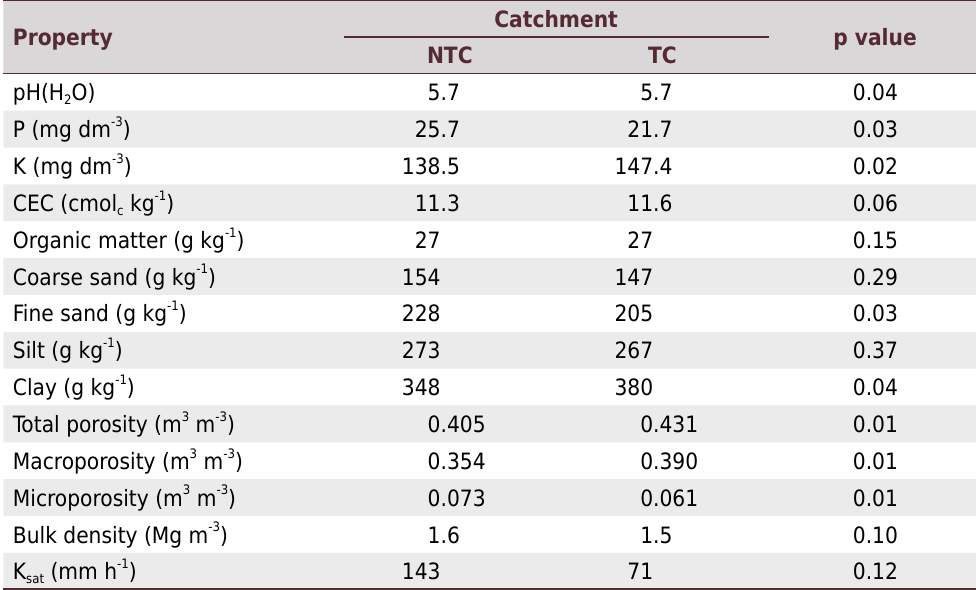
Table 1. Chemical and physical soil properties at 0.00-0.10 m soil layer in the agricultural year 2016/2017, for the non-terraced catchment (NTC) and terraced catchment (TC), in the Rio Grande do Sul state, south